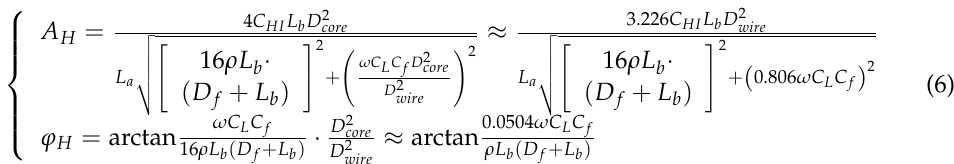
Figure 8. Linear curves of A H - D wire 2 from the model and test under different frequencies.